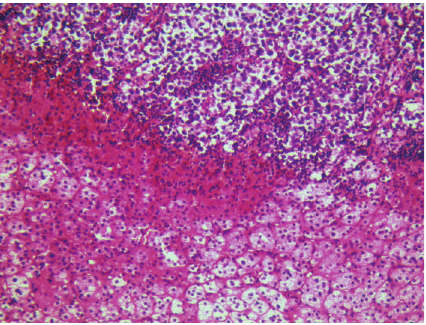
Figure 2: Standard coloration with hematoxylin and eosin showing both tumor and normal adrenal glands ( × 20).